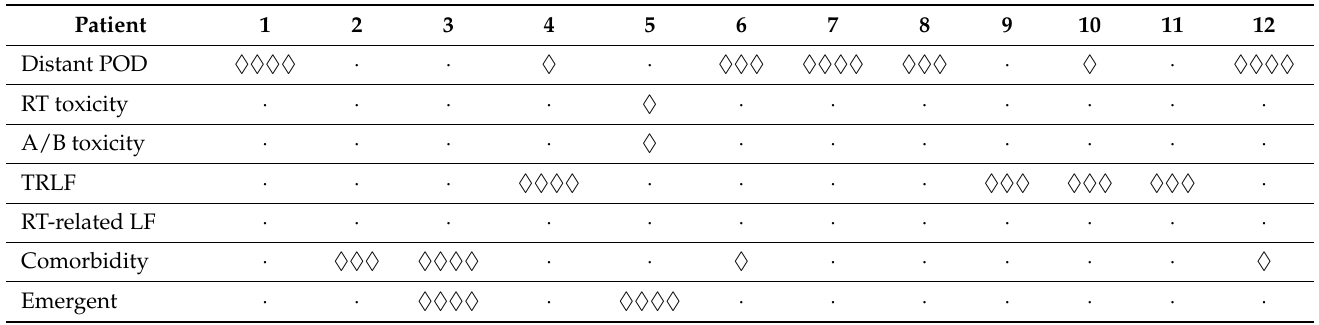
Table 4. Cause of death with attribution to suspected